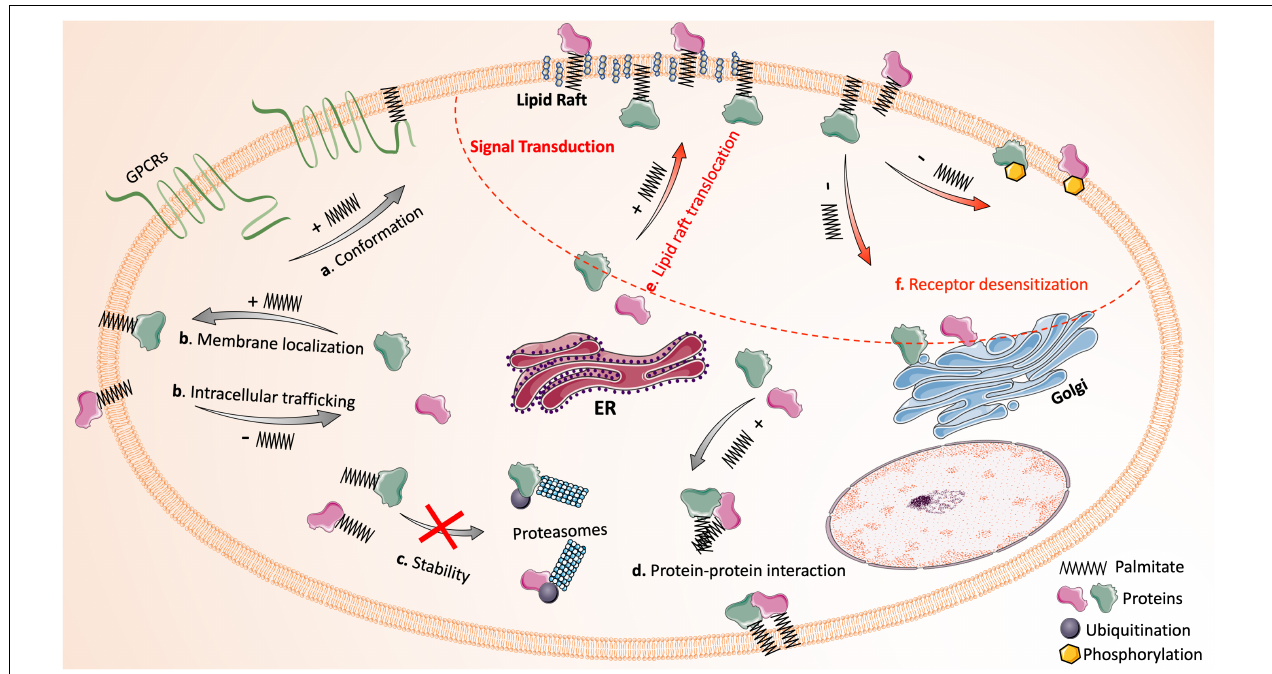
FIGURE 1 | Protein palmitoylation dynamically regulates protein function and signal transduction. The reversible attachment of palmitic acid affects protein function in many ways: (a) palmitoylation alters the conformation or structure of a protein (e.g., the fourth intracellular loop of GPCRs that is formed by inserting palmitate into the plasma membrane); (b) palmitoylation mediates protein intracellular trafficking and ensures stable membrane localization of proteins; (c) palmitoylation stabilizes proteins by preventing misfolding and ubiquitination-mediated degradation; (d) palmitoylation facilitates protein-protein interaction directly and indirectly. In addition, the palmitoylation and de-palmitoylation cycle has critical impact on signal transduction (upper right region circled by red dash line): (e) many signaling proteins require palmitoylation for their translocation into lipid rafts. (f) De-palmitoylation mediates receptor desensitization following activation by promoting the phosphorylation of receptors or the translocation of membrane signaling proteins to cytoplasm. Images of proteins and organelles were obtained from Smart Servier Medical Art